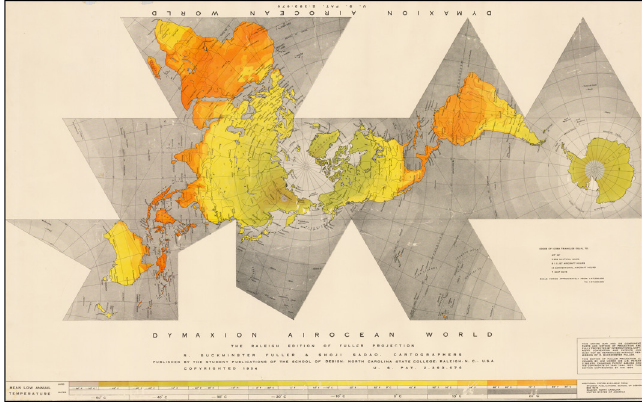
Fig. 20. Fuller’s Airocean World Map (source: portal BLR Antique Maps